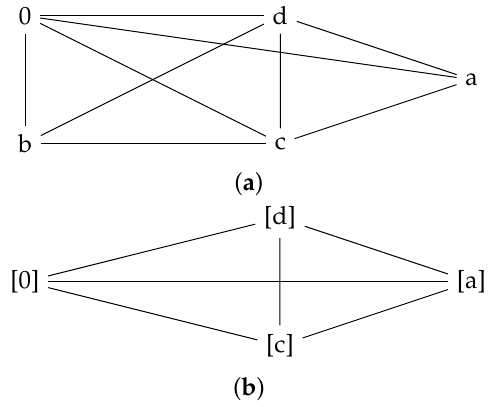
Figure 3. ( a ) Graph of G ( A ) ; ( b ) graph of G E ( A )